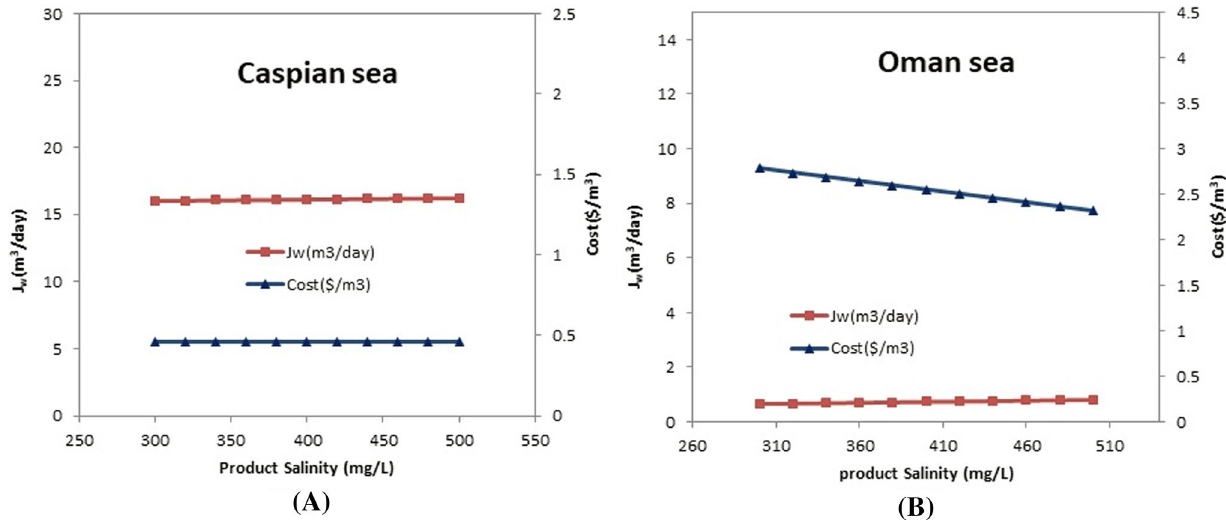
Fig.7 Evaluating the effect of the product water salinity on the cost and permeate flow rate (Δ P = 45 bar, T = 25 °C, R